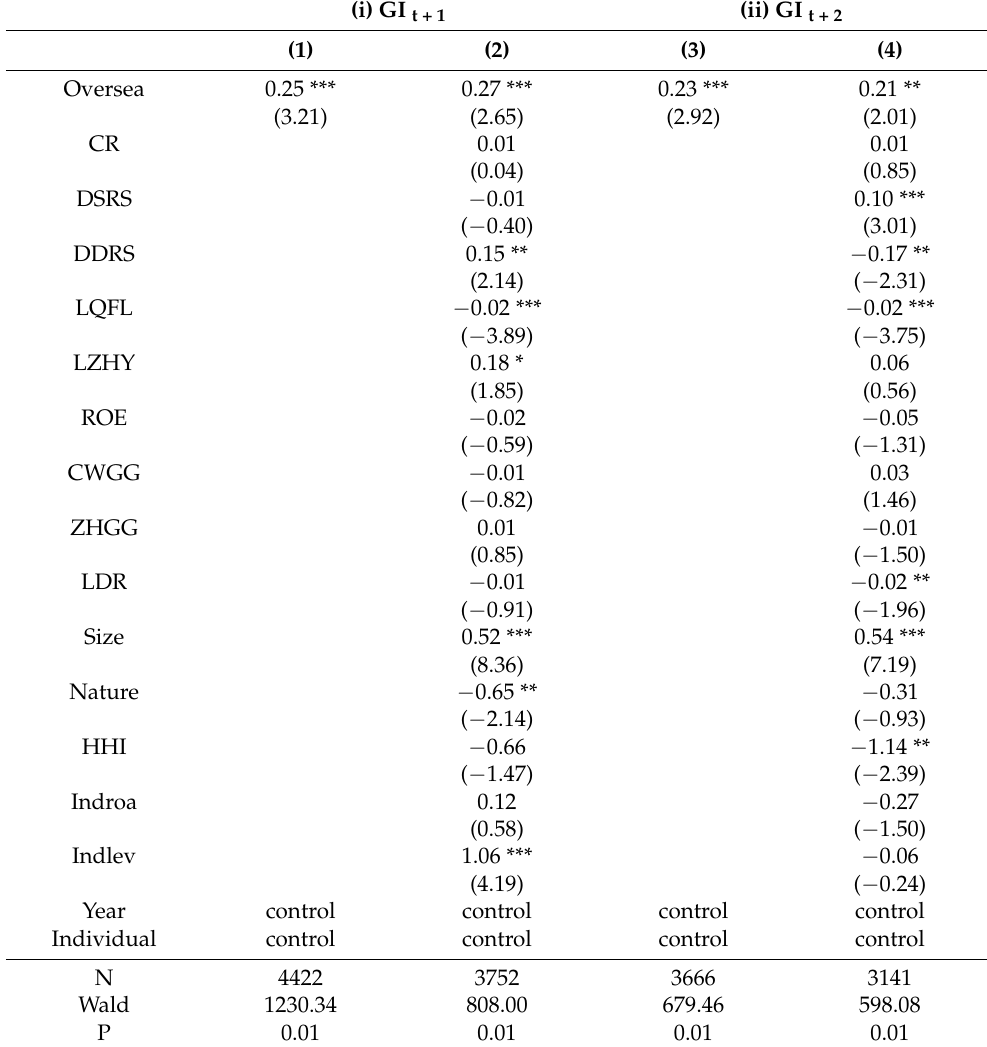
Table 5. Robustness Test—Transforming the explained